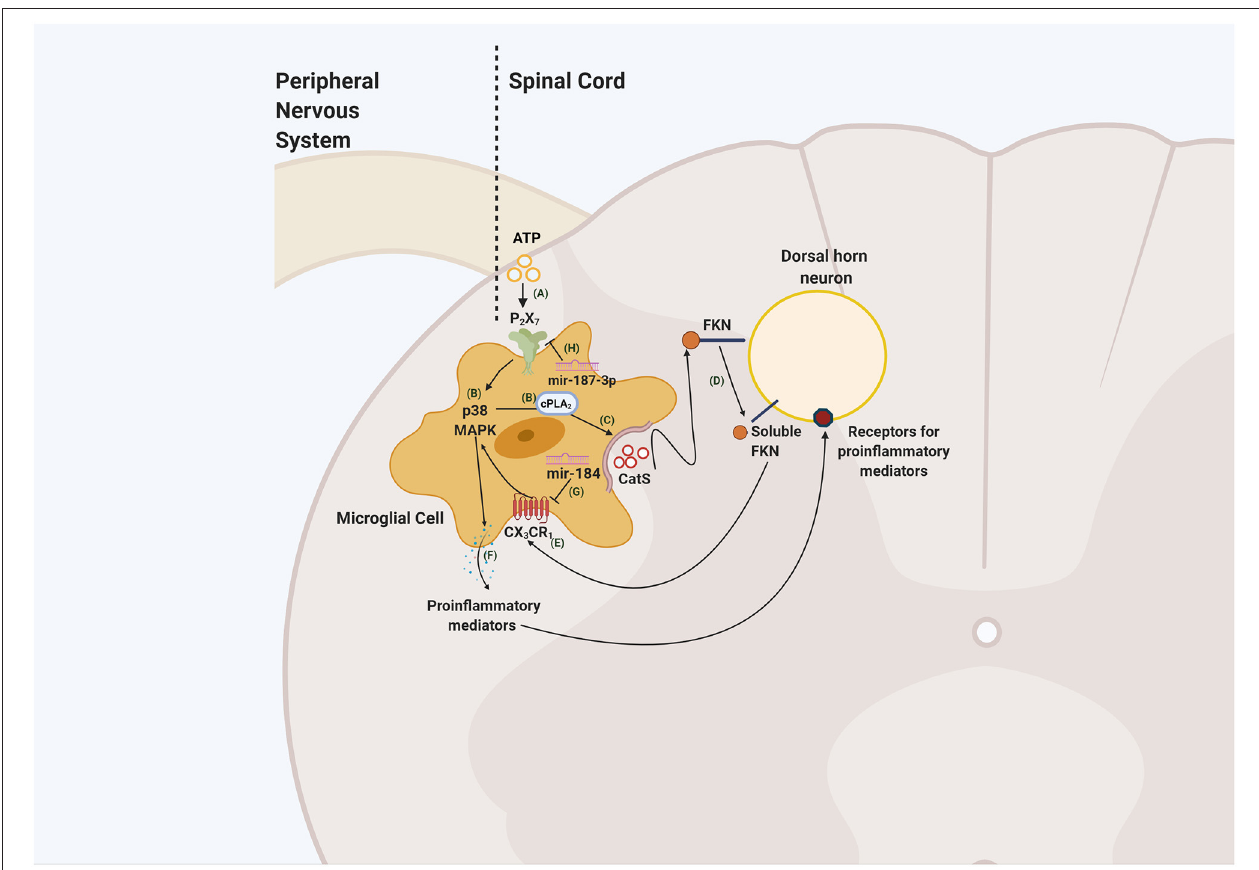
FIGURE 1 | Schematic illustrating neuron-to-glia interaction through the CatS/FKN/CX 3 CR 1 pathway in the spinal cord dorsal horn. ATP released by damaged primary afferents and dorsal horn neurons (A) lead to the activation of P 2 X 7 receptors. The activation of these receptors phosphorylates p38 MAPK signalling pathway and phospholipase A2 (cPLA 2 ) (B) resulting in the release of CatS (C) . CatS cleaves FKN present in the membrane of the spinal cord dorsal horn neuron (D) . The soluble form of FKN interacts with the CX 3 CR 1 receptor located in microglia (E) that phosphorylates p38 MAPK, induces the release of proinflammatory mediators (F) that may sensitise spinal cord dorsal neurons and contribute to the development of central sensitisation and neuropathic pain. Mediating the expression of mir-184 inhibits the activation of CX 3 CR 1 (G) consequently reducing the release of proinflammatory mediators and microglial activation. On the other hand, upregulating mir-187-3p (H) through the administration of its mimic, downregulates P 2 X 7 expression, potentially disrupting the liberation of CatS. This figure was created with